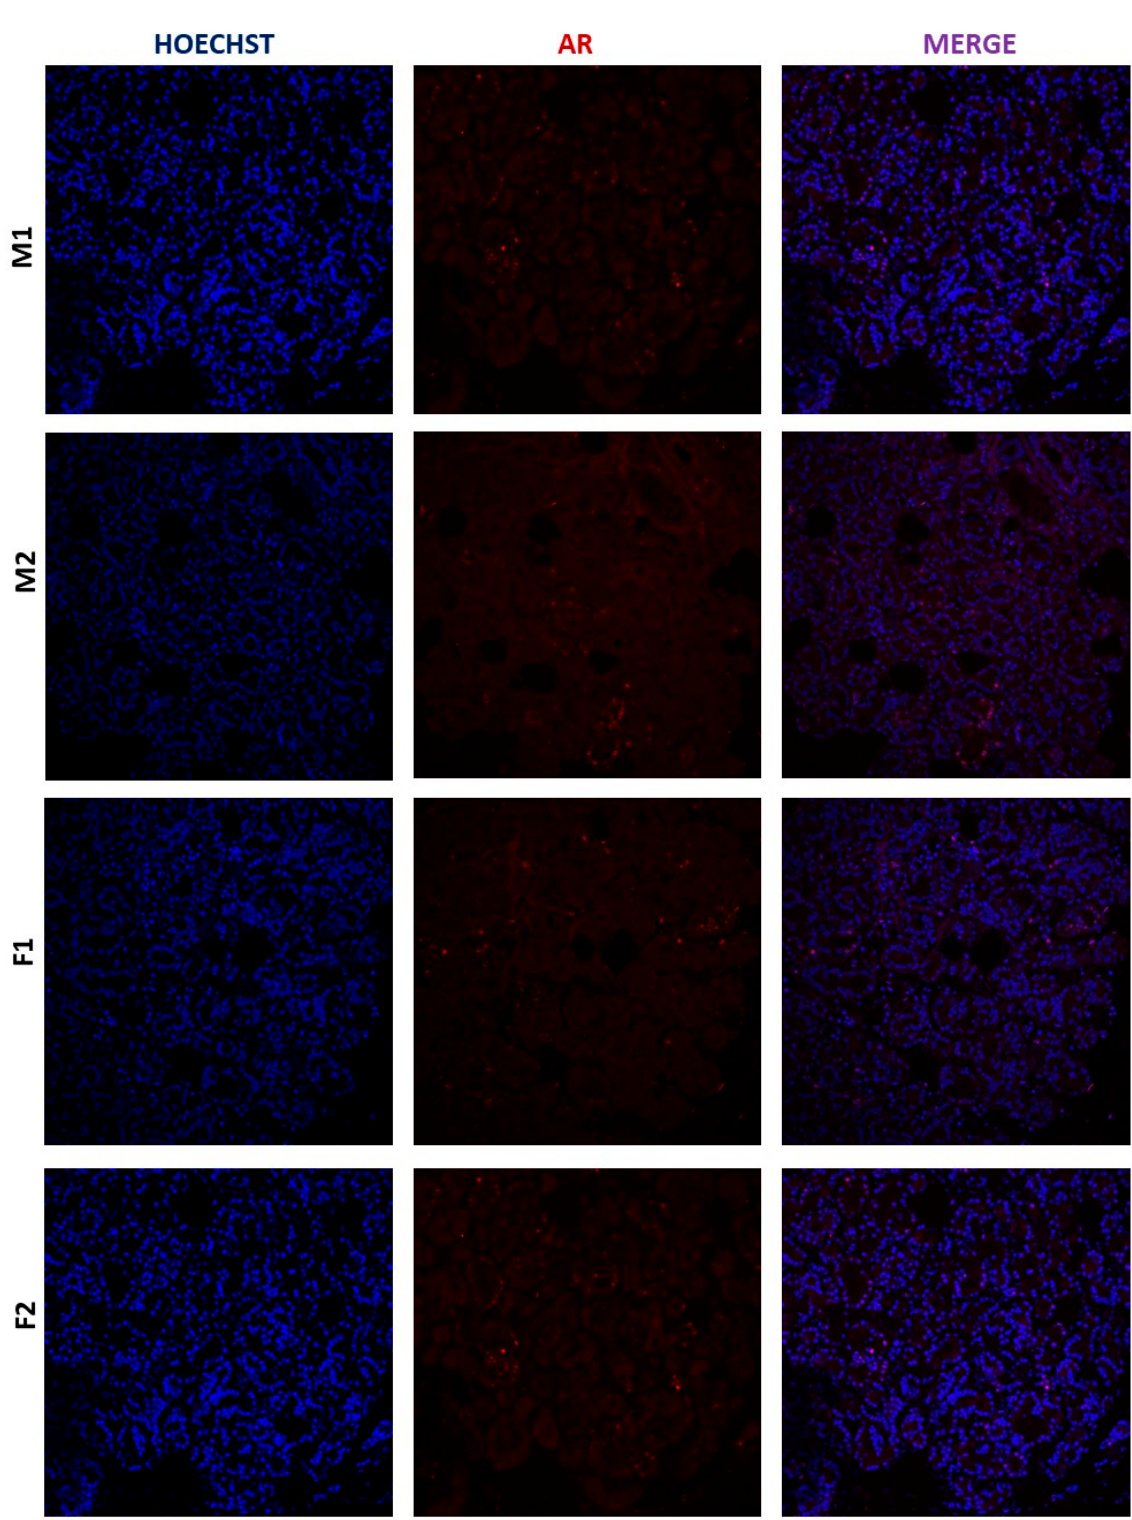
Figure 6. AR expression in the human lacrimal gland, magnification 20 × . (M1—male lacrimal gland sample 1, M2-male lacrimal gland sample 2, F1—female lacrimal gland sample 1, F2- female lacrimal gland sample 2).